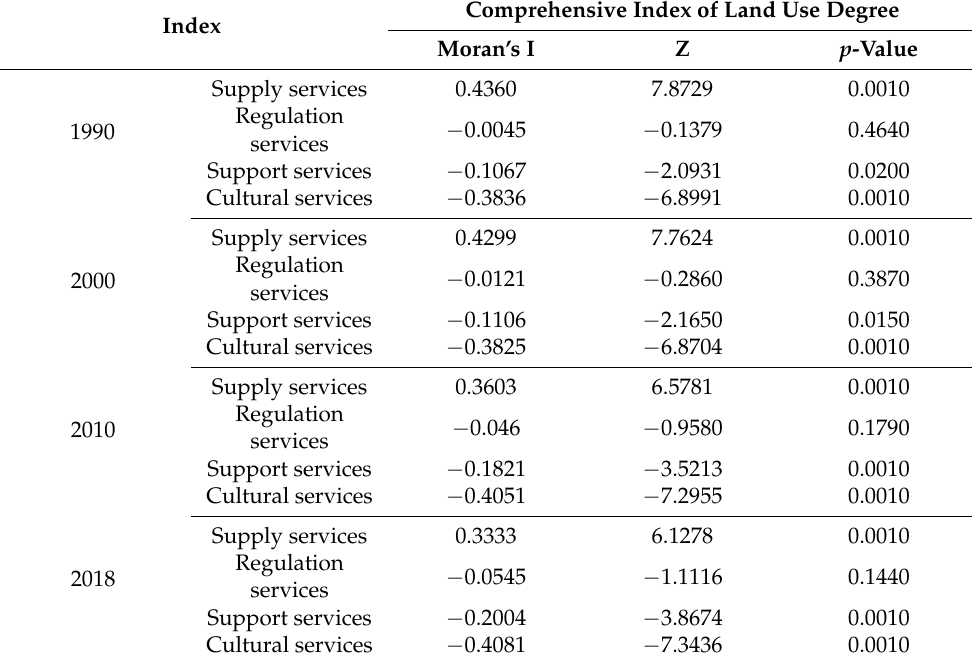
Table 5. Bivariate spatial autocorrelation between land use degree and